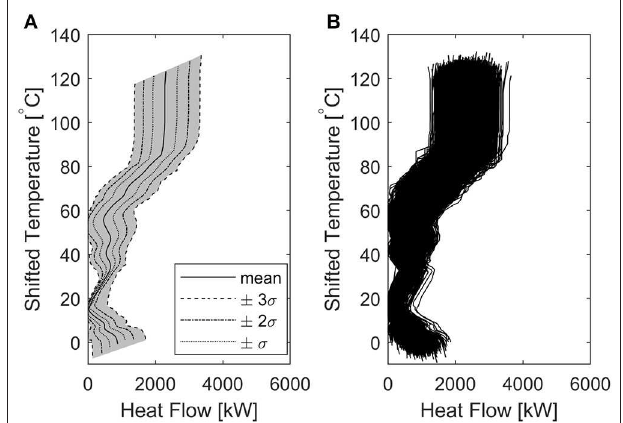
FIGURE 11 | Grand Composite Curve considering reduced uncertainties for the k =28 parameters (